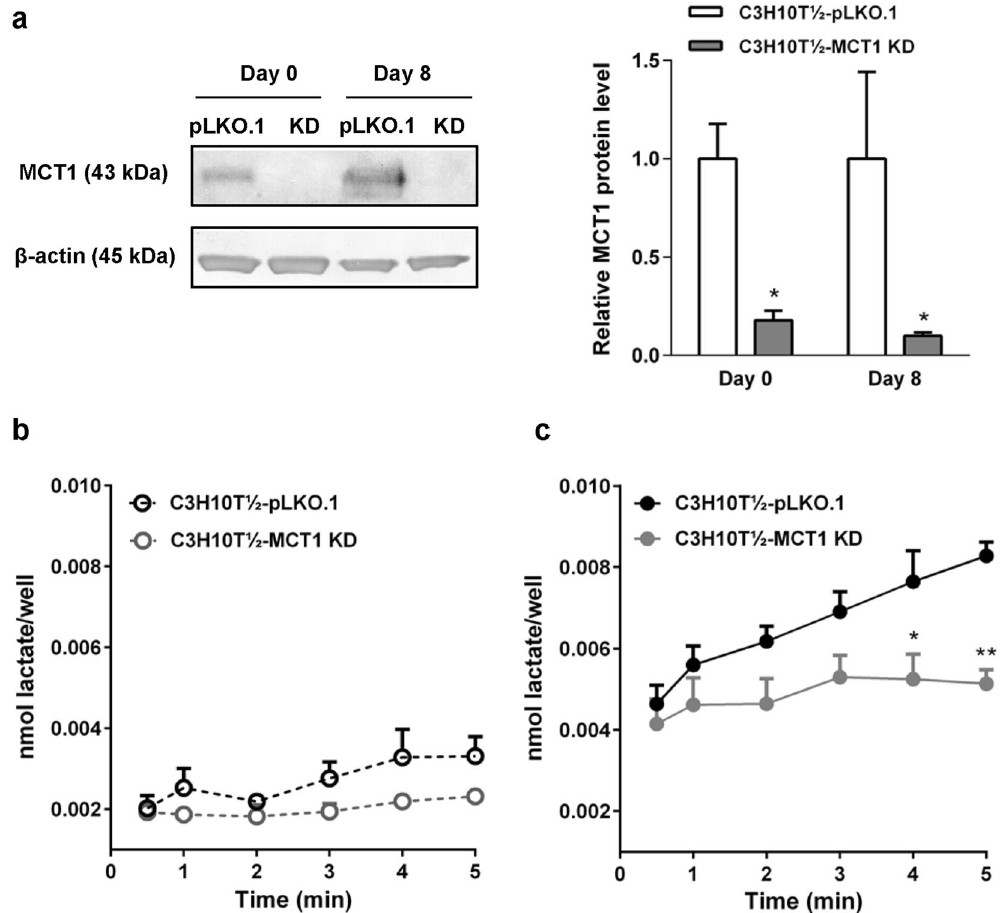
Figure 5. Lactate influx in C3H10T½ cells is attenuated by stable knockdown of MCT1. MCT1 was stably knocked down in C3H10T½ cells by lentiviral shRNA transduction as described in Materials and Methods. ( a ) Relative MCT1 protein levels in C3H10T½ cells expressing empty control plasmid (pLKO.1) or MCT1 shRNA (KD), at day 0 (undifferentiated) and day 8 after differentiation induction. β -actin is shown as loading control. Membranes were cut horizontally before blotting and edges slightly cropped for presentation. The bar chart shows mean data from 3 independent experiments, normalized to control values at day 0 and day 8. ( b ) Tracer measurements of lactate influx were carried out as described in the legend to Fig. 4, and net influx calculated as nmol lactate ·well − 1 before ( b ) and after ( c ) differentiation. The figure shows means with SEM error bars of 3 independent biological replicates for pLKO.1 (black symbols) and MCT1 KD (gray symbols) cells. * , ** p < 0.01, Two-way ANOVA. Using linear regression of the data in b and c to calculate the flux, and correcting for the fact that MCT1 KD reduced the growth of the cells, resulting in approximately 30% lower protein levels, average fluxes of 0.67 nmol lactate · g protein − 1 · min − 1 in undifferentiated pLKO.1 control cells, 0.32 nmol lactate · g protein − 1 · min − 1 in undifferentiated MCT1 KD cells, 1.41 nmol lactate · g protein − 1 · min − 1 in